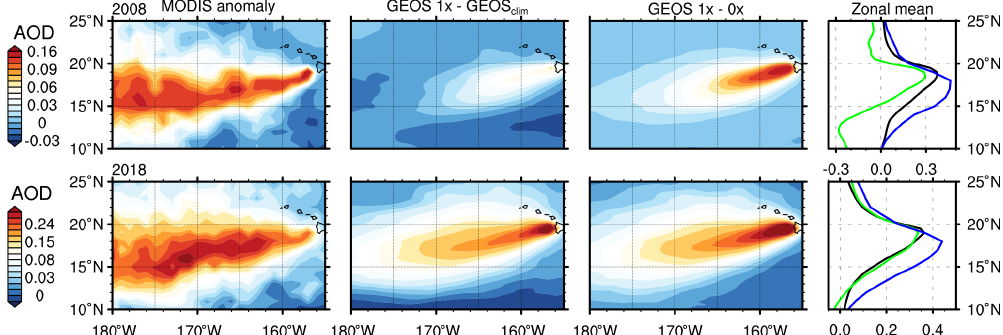
Figure 2. AOD anomalies (from left) for MODIS observations and for GEOS simulations using actual emissions (2008_1 × and 2018_1 × ) calculated against GEOS CLIM and the zero-emissions scenarios (2008_0 × and 2018_0 × ) during JJA 2008 (top panels) and MJJ 2018 (bottom panels). The rightmost column shows normalized zonal mean anomalies for MODIS (blue) and GEOS against GEOS CLIM (green) and zero emissions (black).